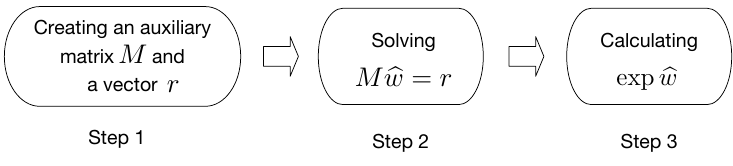
Figure 1. Scheme of the